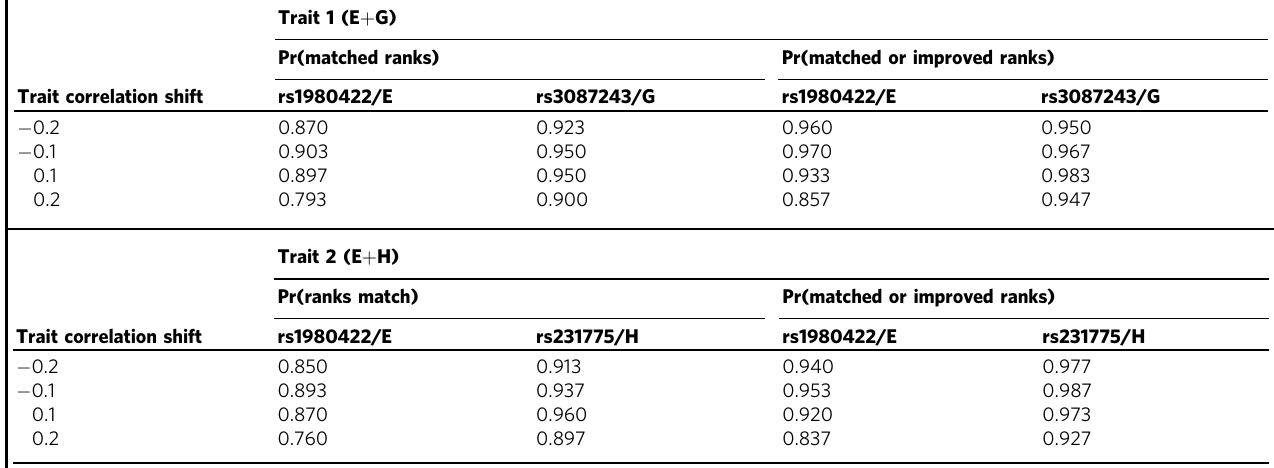
Table 3 Probabilities describing the relationship between fl ashfm ranks of causal variants when the trait correlation is mis- speci fi